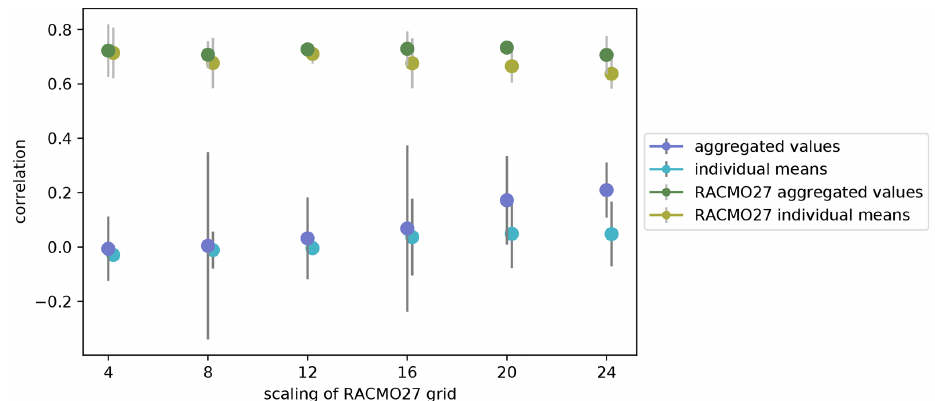
Figure 10. SMB–SAT annual correlation as a function of grid spacing for the aggregated records vs. mean of the individual annual cor- relations for the ice cores (dark and light blues, respectively) and RACMO27 simulations (in dark and light green, respectively). The grey bars indicate the full range of correlation values with the mean indicated by the colored dot. For the RACMO27 simulation results, only RACMO27 grid cells where ice cores exist are used. For both ice cores and RACMO27, only grid points with at least five ice cores are kept. Annual correlations are over the 1958–2010 time interval for the ice core data and over 1979–2016 for the RACMO27